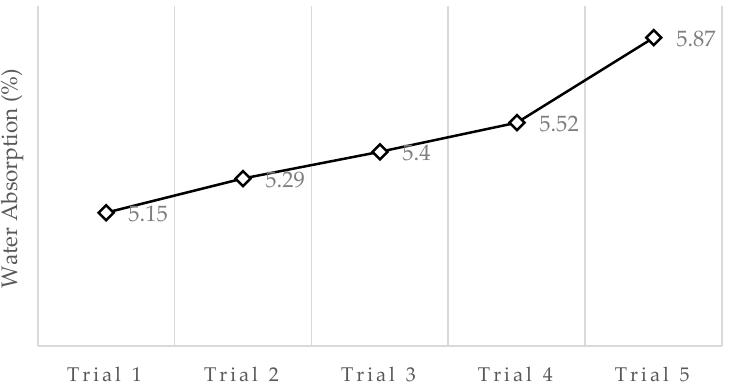
Figure 3. Water absorption results for brick samples.